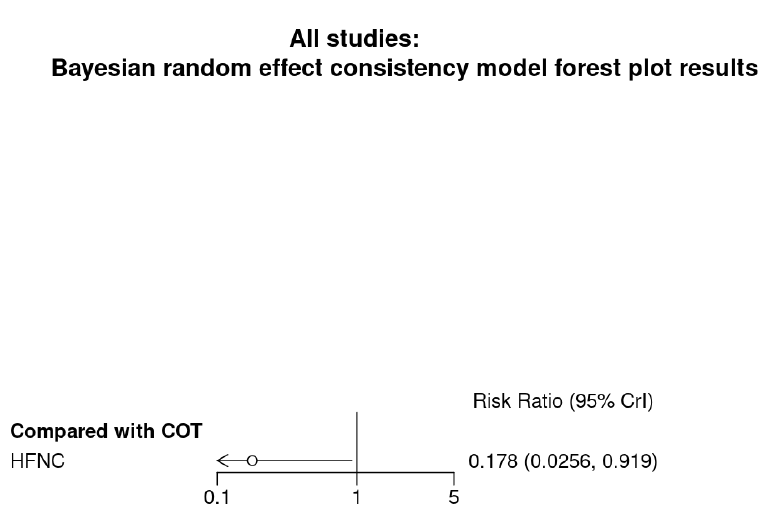
Figure A8. Bayesian random effect consistency model Outcome: Need for minor airway interventions.